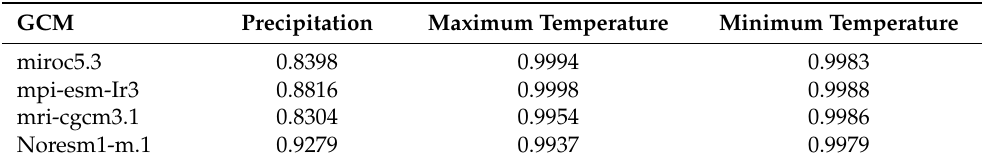
Table 3. Correlation coefficient (R 2 ) of historical records from Morgantown Municipal Airport and historical simulations of GCMs from 1950–1980 at a monthly scale under RCP 4.5 for precipitation, minimum and maximum temperature.